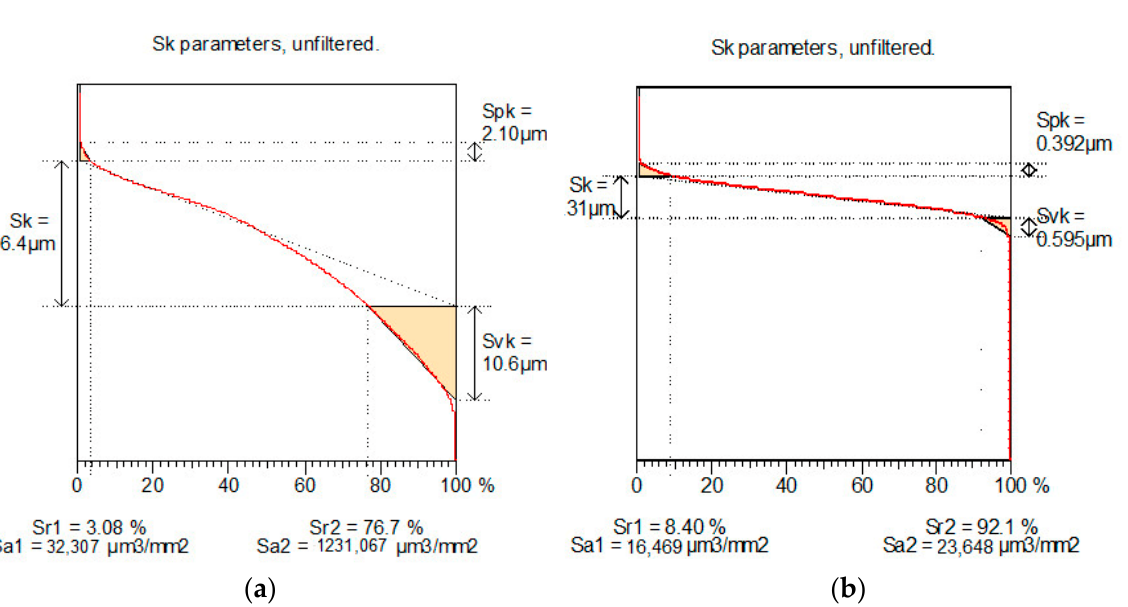
Figure 9. Vectorization of the microgroove network ( a ) for base surface and ( b ) after burnishing 𝑃 = 60 N , 𝑓 = 1500 mm/min (experimental run no. 9).